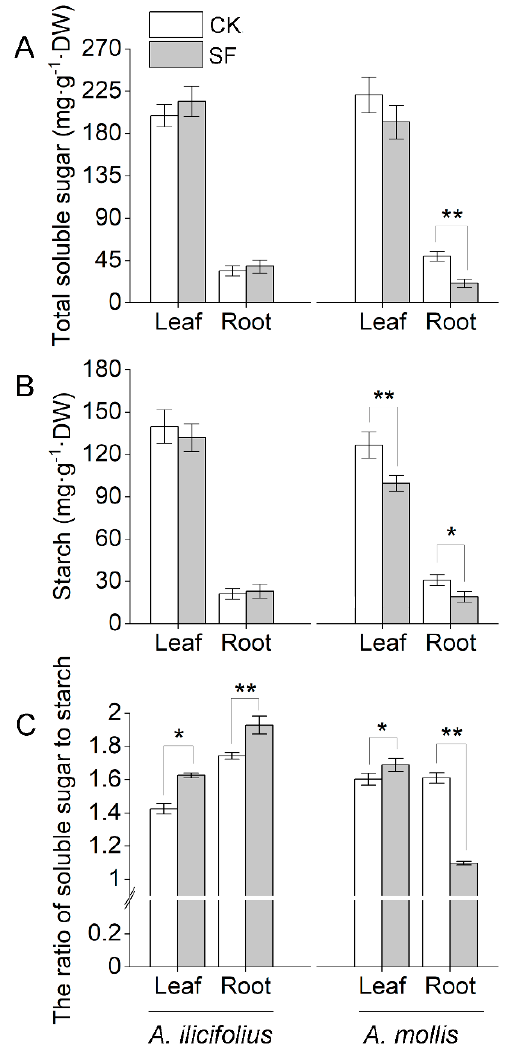
Figure 8. The concentration of ( A ) soluble sugar, ( B ) starch and ( C ) the ratio of soluble sugar to starch for A. ilicifolius and A. mollis under tenth day tidal flooding stress. * and ** indicate significant difference at the 0.05 level and the 0.01 level, respectively. CK and SF represent control and soil tidal flooding stress, respectively.